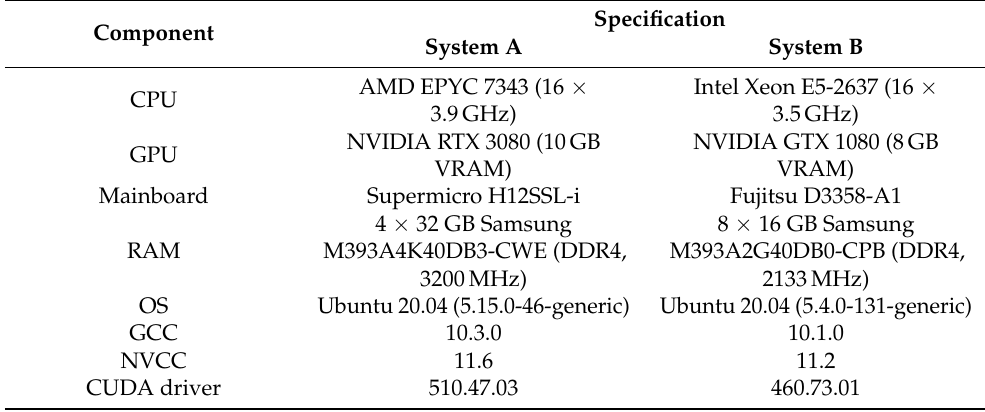
Figure 3. Examples of the used images from the YACCLAB dataset. White pixels are considered foreground pixels. Table 1. Benchmark system